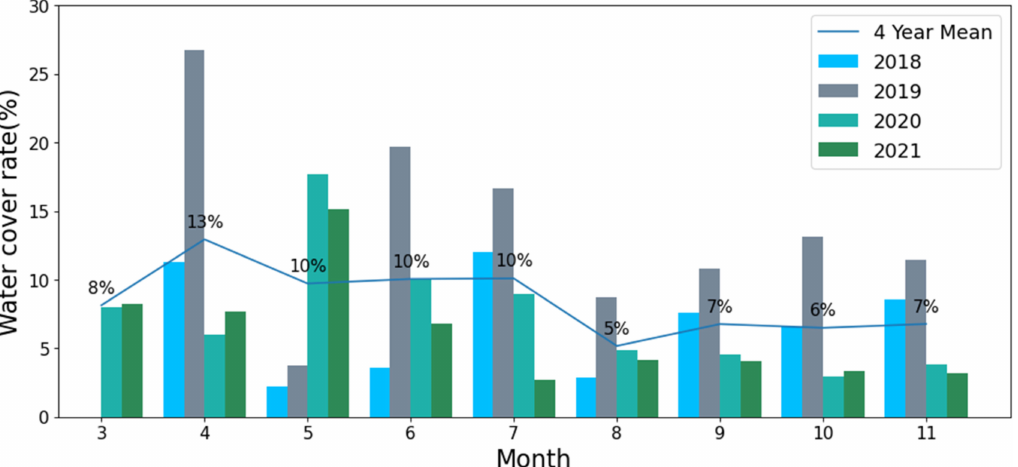
Figure 3. The mean water cover rate by area for all CEs during